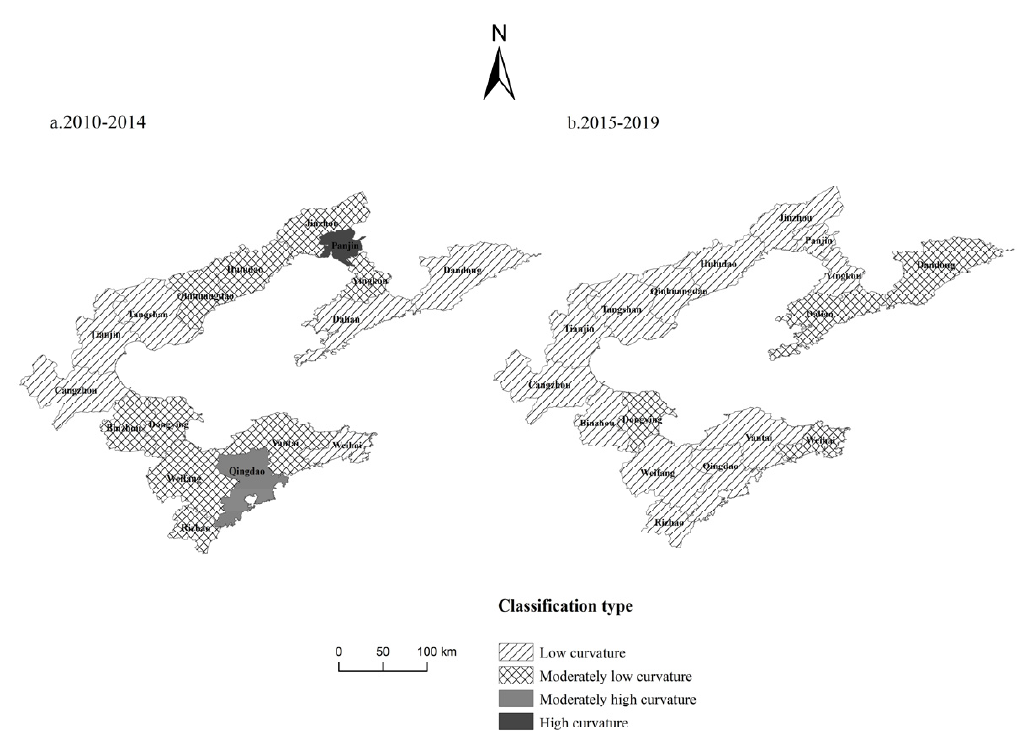
Figure 6. Tortuosity of the local indicators of the spatial association time path. Source: own study. Figure 5. Relative length of the local indicators of the spatial association time path. Source: own study.